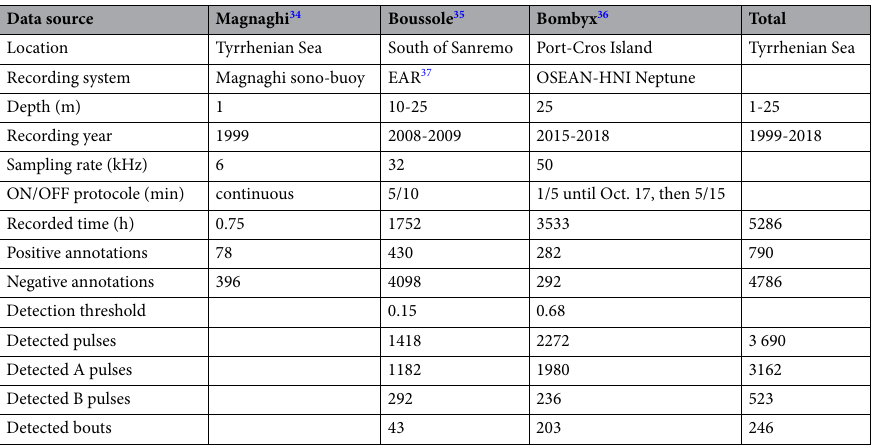
Table 1. Summary of the recording characteristics for each source. The data from Magnaghi was only used in the CNN training, not in the subsequent analysis.